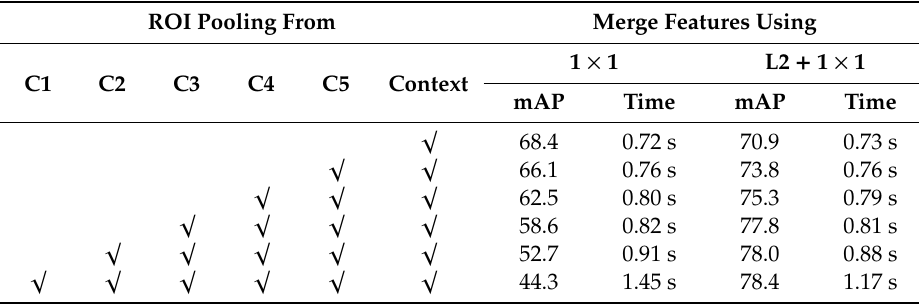
Table 2. E ff ect of combining features from di ff erent layers on detection accuracy. ROI Pooling From Merge Features